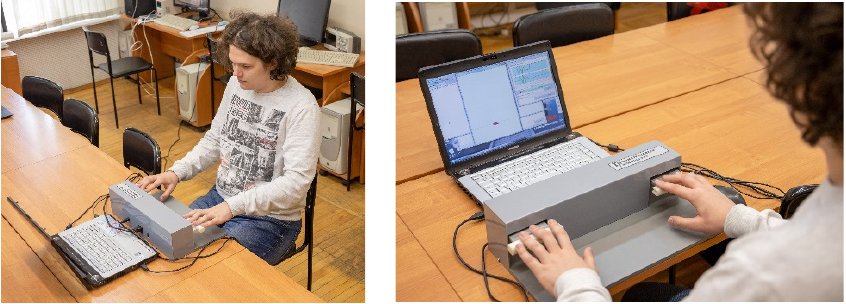
Figure 1. Testing procedure.